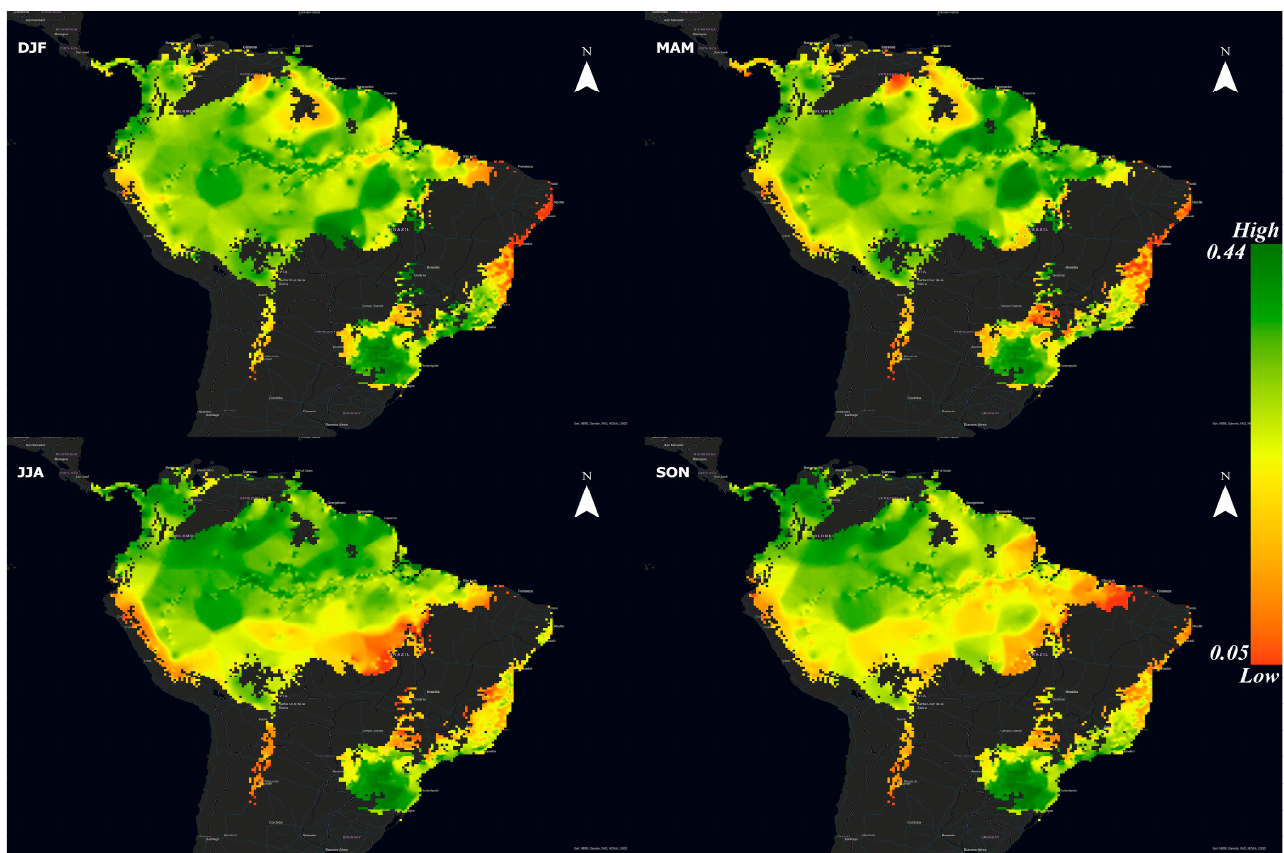
Figure 4. VSM spatial climate change (m 3 m − 3 ) for the 2001–2021 climate quarters.